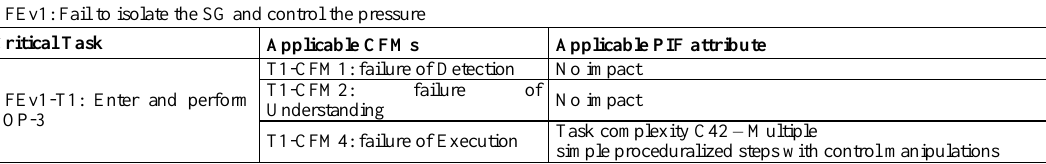
Table 2. Summary of CFMs/PIFs in